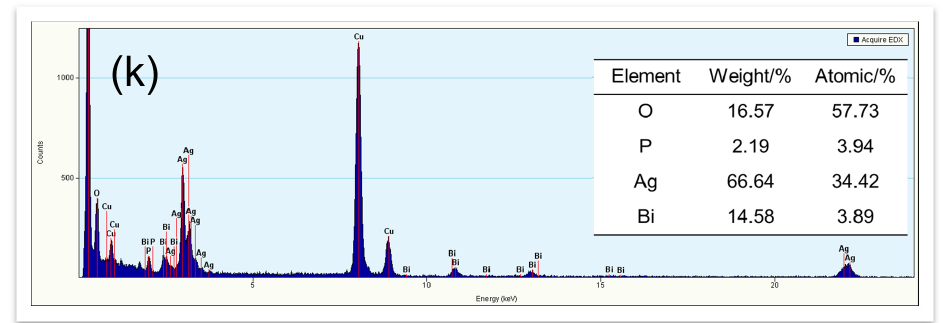
Figure 3. TEM, high resolution transmission electron microscopy (HRTEM), and energy dispersive X ‐ ray spectrum (EDX) patterns of the photo ‐ catalysts ( a , b ) Bi 2 O 2 CO 3 ; ( c , d ) 10 wt% Ag/Bi 2 O 2 CO 3 ; ( e , f ) 64 wt% Ag 3 PO 4 /Bi 2 O 2 CO 3 ; ( g , h ) 71 wt% Ag 3 PO 4 /Ag/Bi 2 O 2 CO 3 ; ( i , j ) reused 71 wt% Ag 3 PO 4 /Ag/Bi 2 O 2 CO 3 ; and ( k ) EDX image of 71 wt% Ag 3 PO 4 /Ag/Bi 2 O 2 CO 3 .